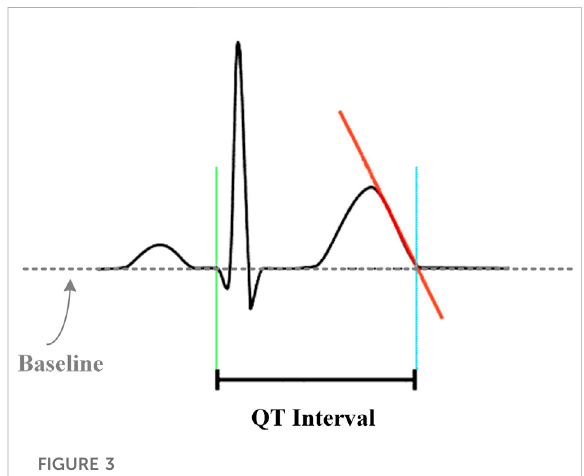
FIGURE 3 Schematic diagram of the QT interval measuring